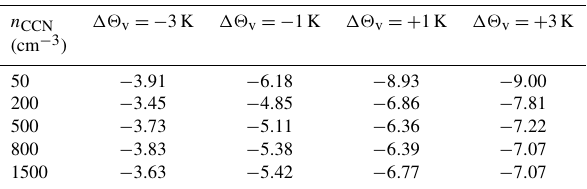
Table A3. Temperature sensitivity (in %K − 1 ) of melting for all n CCN values.